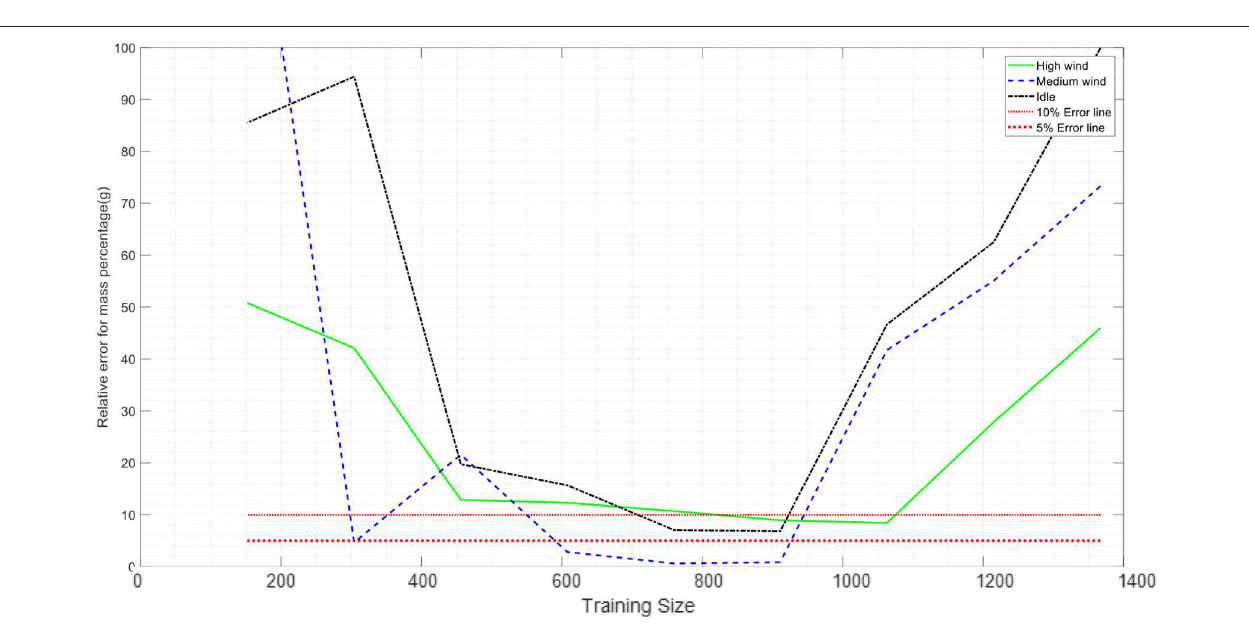
FIGURE 10 | Variation predication of firebrands’ mass and flying distance correlation with sample